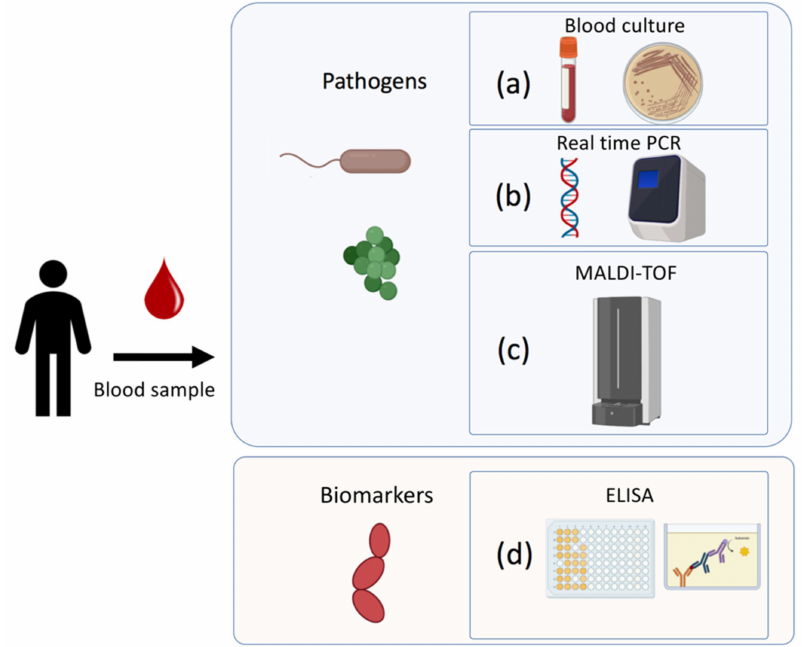
Figure 2. Traditional techniques to detect pathogens and biomarkers associated to sepsis: ( a ) Blood culture-based approach for microorganism identification; ( b ) DNA/RNA amplification-based tech- nique (RT-PCR); ( c ) Matrix-Assisted Laser Desorption/Ionization Time-of-Flight Mass Spectrometry; ( d ) Immunoenzymatically serological assay for biomarkers